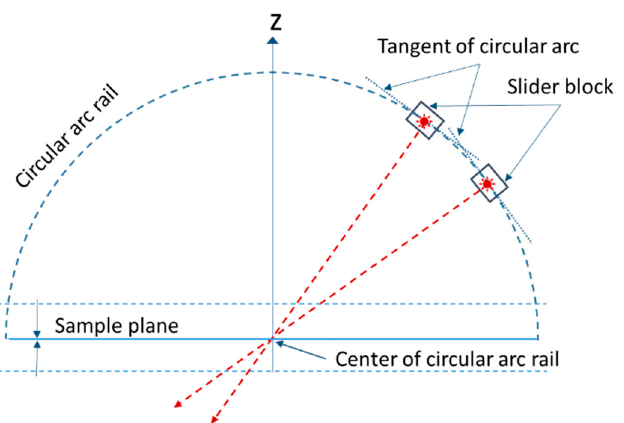
Figure 2. Sample platform plane identification and rotation center calibration. The intersection of the two laser sources pointed toward the center of the circular motion rail indicates the best focus position for the sample plane.